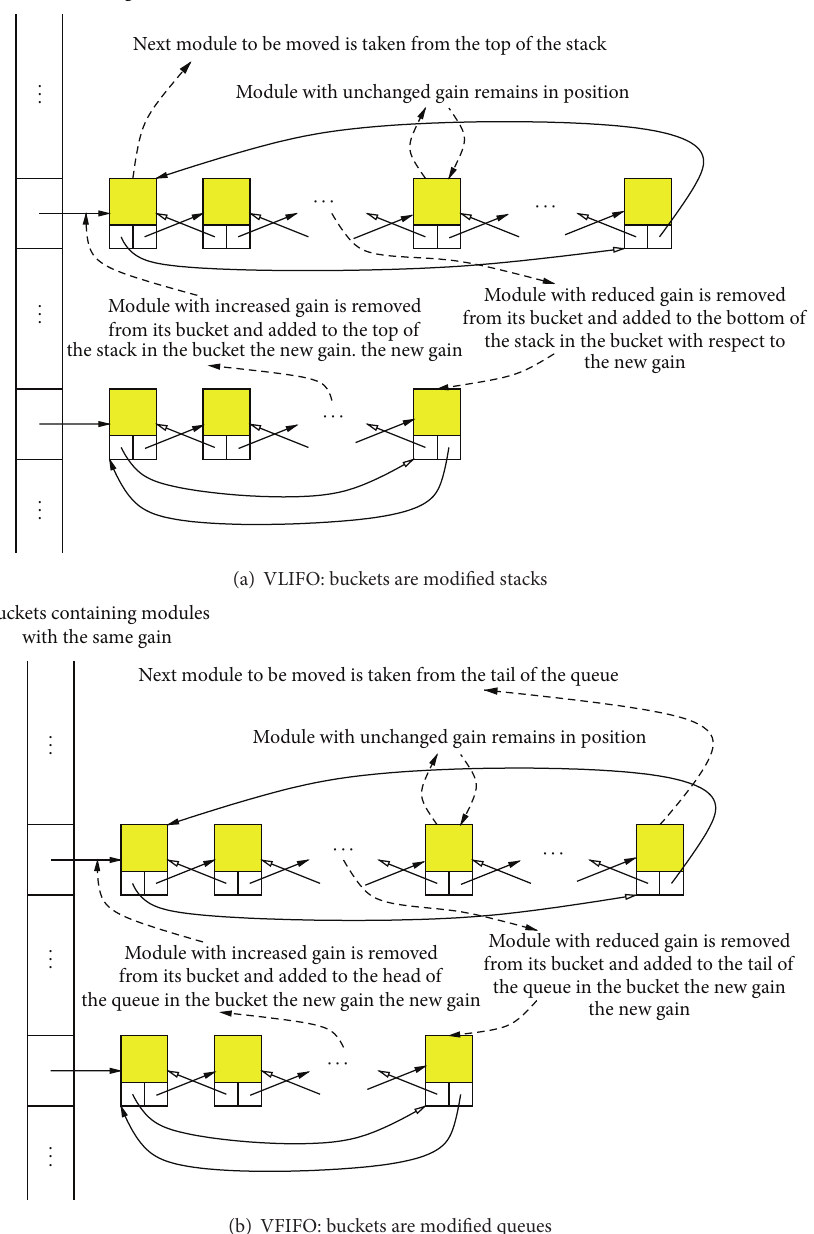
Figure 3: VLIFO and VFIFO management of gain